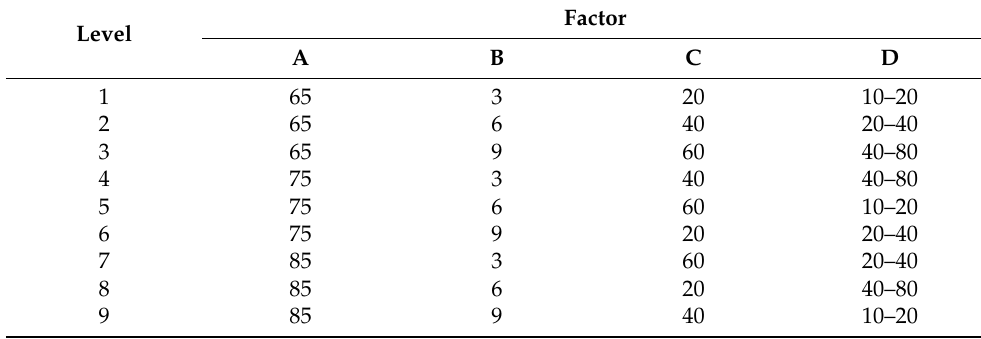
Table 2. Orthogonal test scheme of the